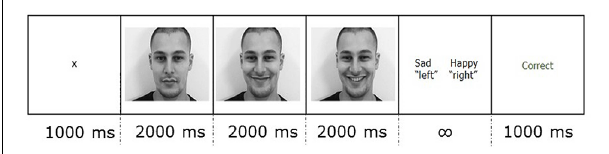
FIGURE 1 | An example of a trial showing the duration of each section in ms. Each condition video was presented for 6,000 ms of which the first 2,000 ms was static, the second 2,000 ms was dynamic, and the last 2,000 ms was static. on the right was correct. In half of the trials, the correct label was on the right, and in half, on the left. Each trial ended with a 1,000 ms feedback slide. The feedback slide displayed the word ‘‘Correct’’ or ‘‘Incorrect’’ depending on the key